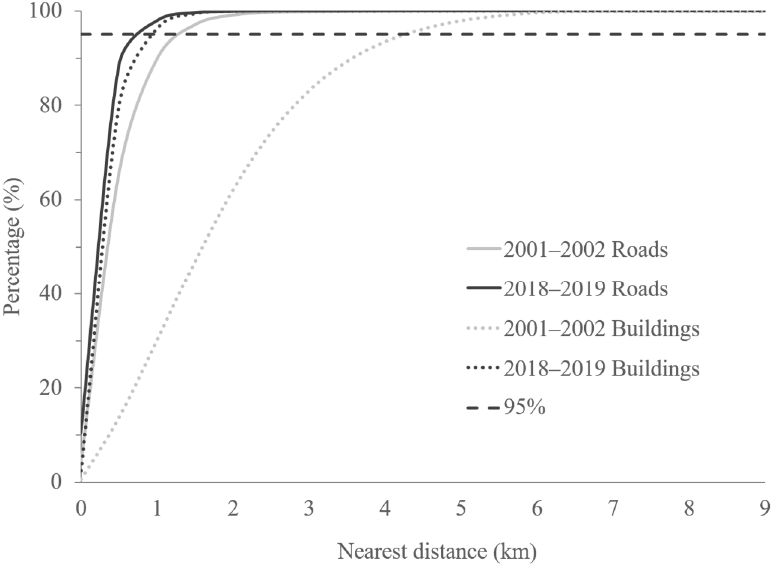
Figure 2. Percentage of lands by distance to the nearest road or building at the study site in the Dabie Mountains, China.